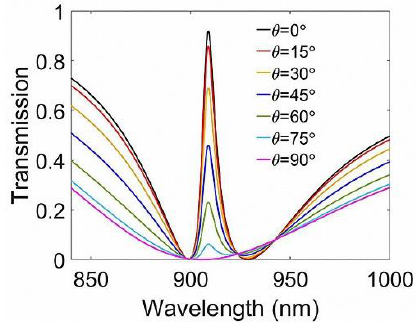
Figure 4. Simulated transmission spectra with different incident polarization angles.